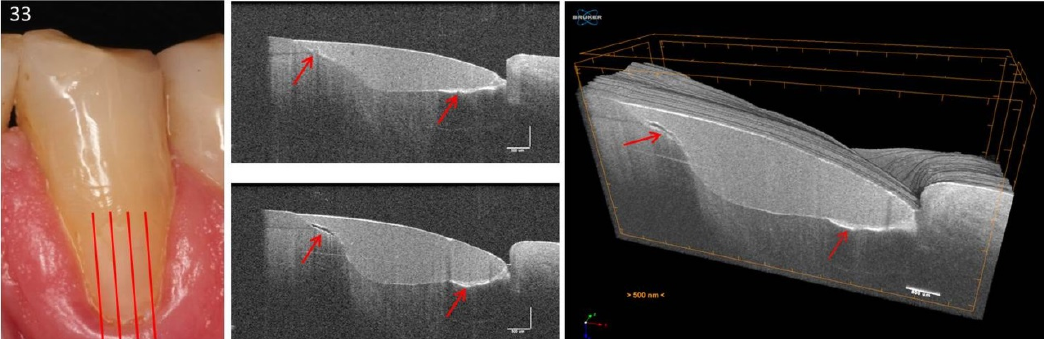
Figure 16. Chromasit ® inlay on tooth 24 after 22 years of clinical service. The OCT-B scan of the tooth-restoration interface shows an extended marginal and deep interfacial gap (position 2, bright signal line) without signs of secondary caries. At and beneath the enamel-dentin junction, a bright zone indicates a carious lesion at the tooth-composite contact zone or a cracked zone in the bonding composite (C / L 1?). Gap 1 is the gap between the teeth (short bright signal line). The restoration materials C1 (dentin color) and C2 (enamel color) contain single bubbles (B). A proximal lesion L 2 on tooth 25 mesial is visible, which could also be confirmed tactile (ICDAS, code 3) after OCT imaging (verification). Composite (C), enamel (E), dentin (D). Refractive index n = 1.0 (see Figure 4).